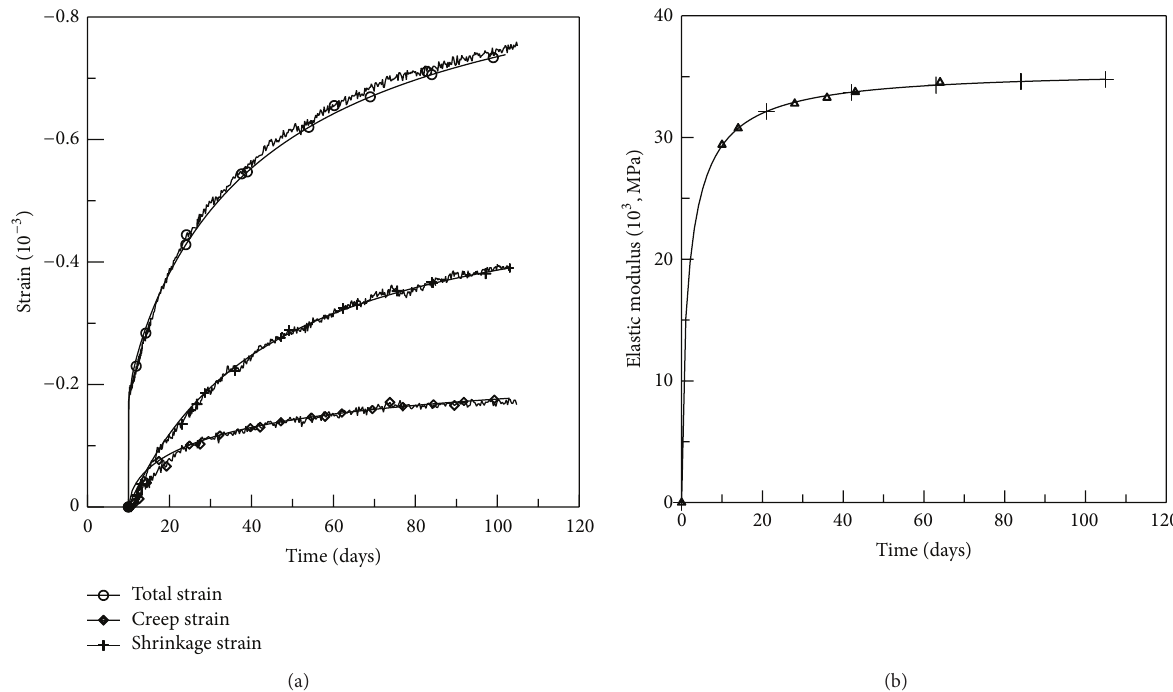
Figure 5: Basic age-dependent properties of type A test: (a) total, creep, and shrinkage strains, (b) development of elastic modulus.